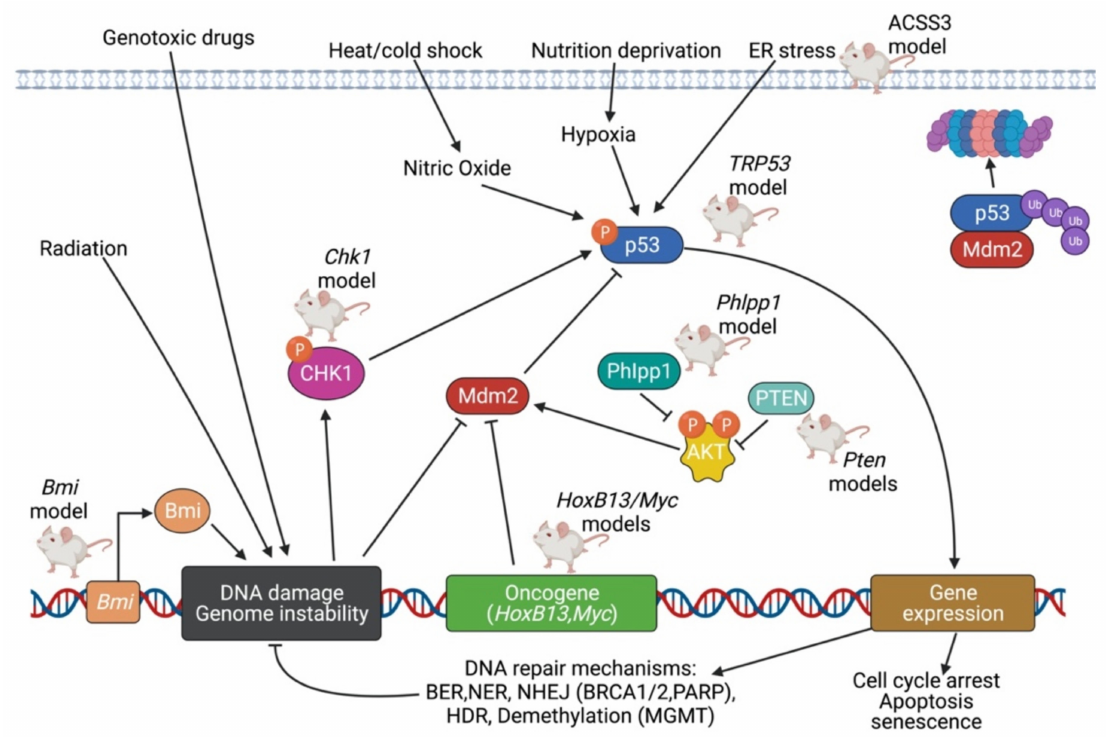
Figure 4. Summary of PCa knockout models due to inhibition of TP53 and DNA repair